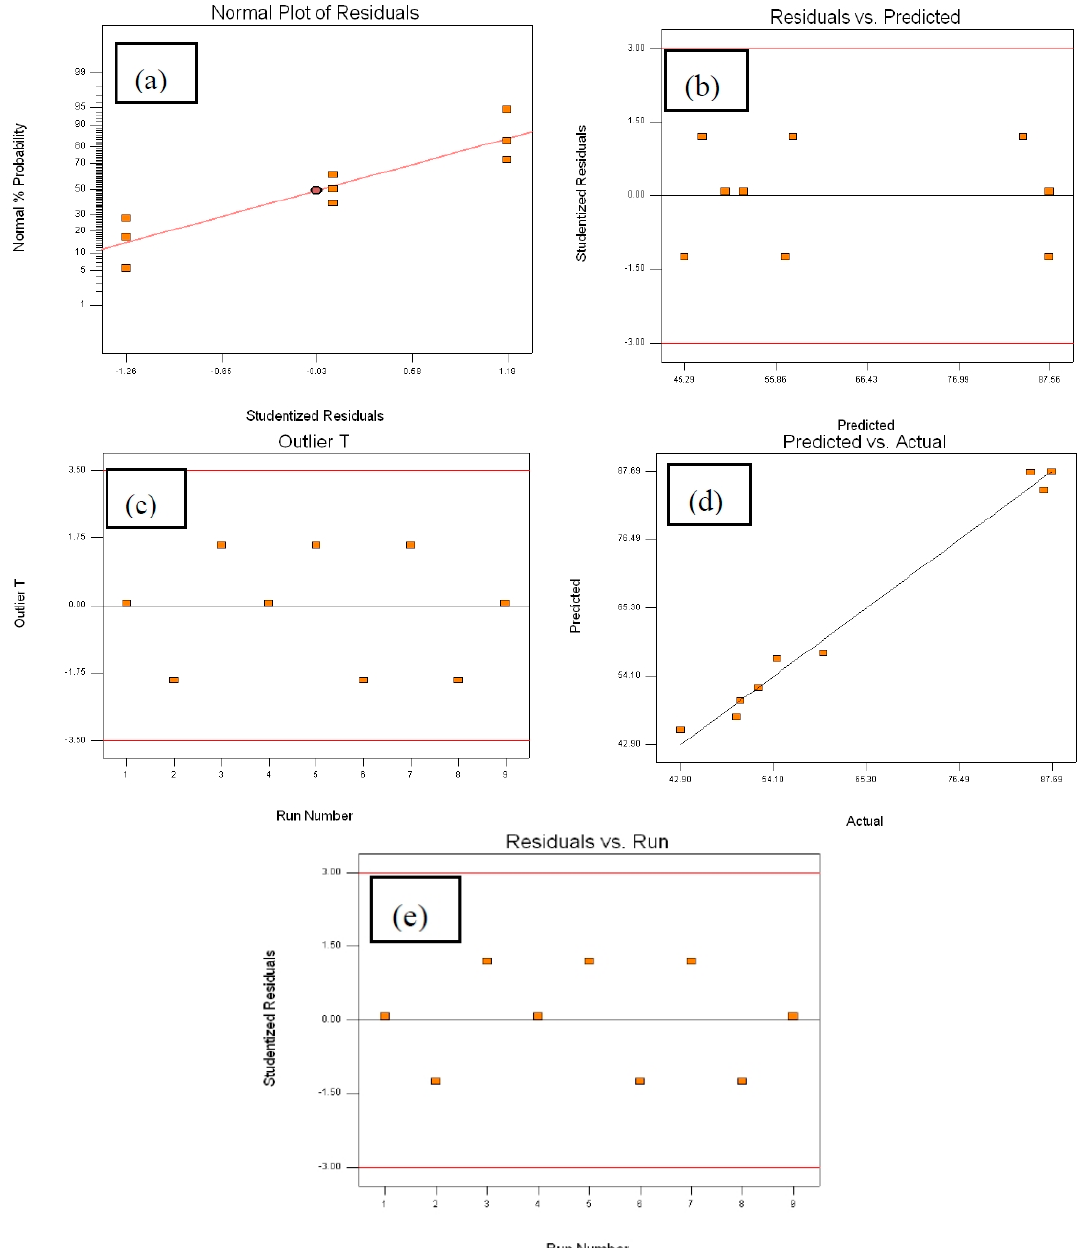
Figure 8. Diagnostic plots of the photocatalytic degradation efficiency percentage (DE%) for the optimization process. ( a ) Studentized residual; ( b ) Residual vs. predicted; ( c ) Outlier; ( d ) Actual vs. predicted; and ( e ) Residual vs. Run.